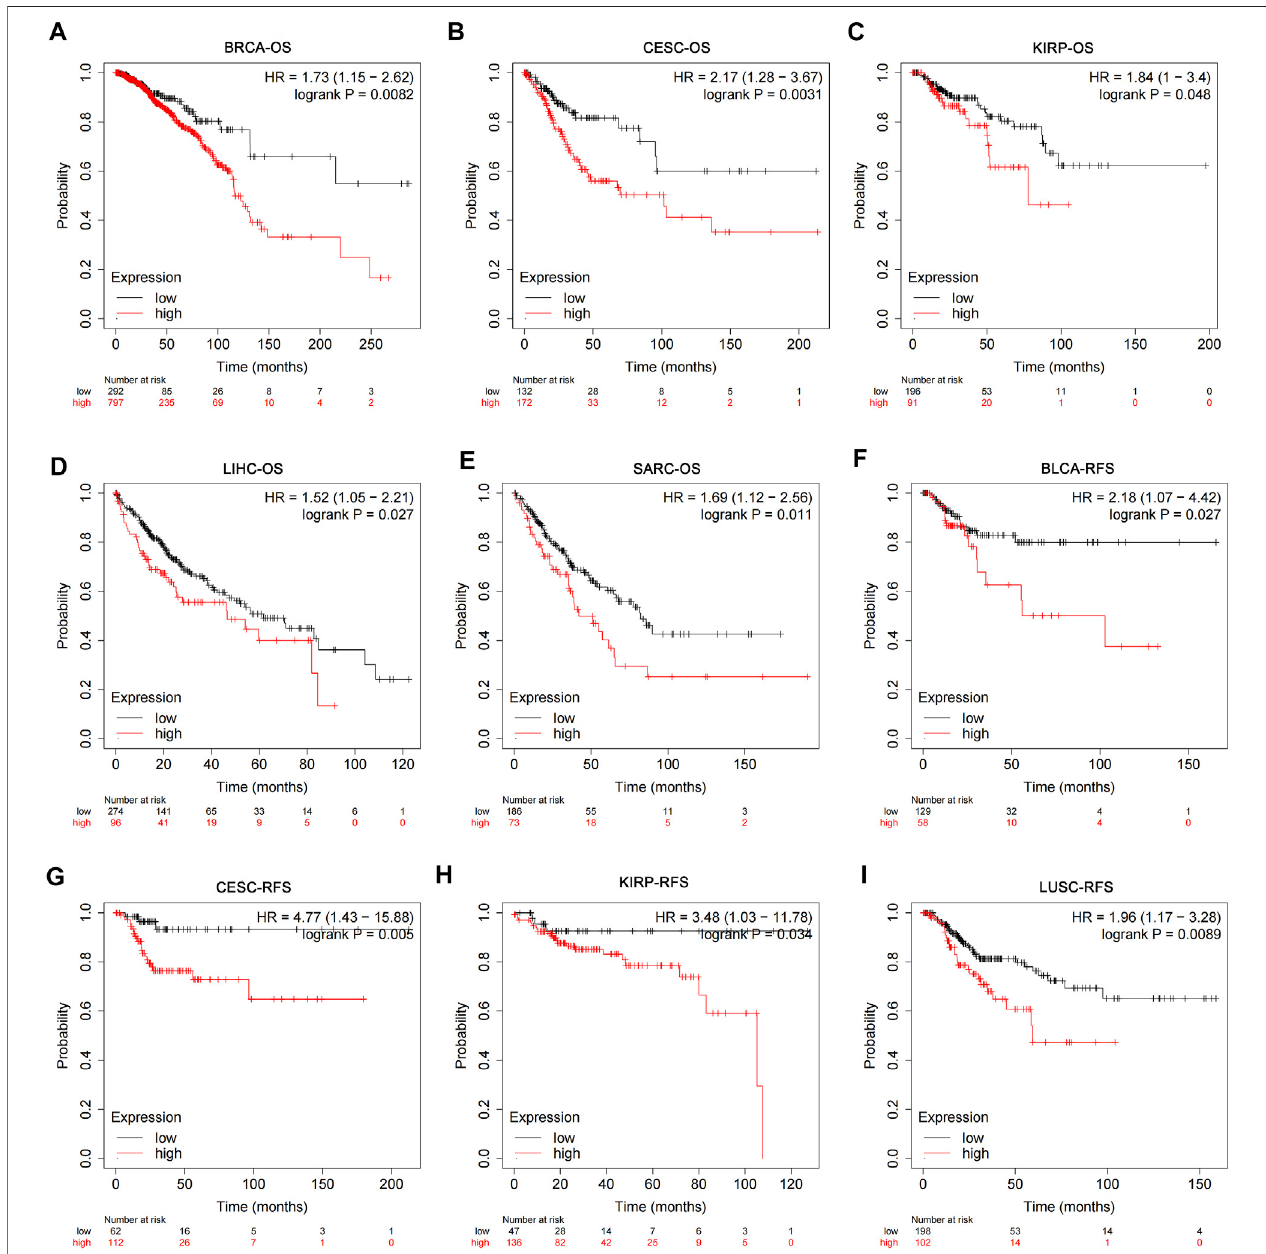
FIGURE 2 | Correlation analysis of USP45 with OS and RFS in patients with different types of tumors. The RNA-seq data and corresponding clinical information of different types of tumors were downloaded from TCGA database. The expression levels of USP45 were negatively correlated with OS of patients with BRCA (A) , CESC (B) ,KIRP (C) ,LIHC (D) ,andSARC (E) .TheexpressionlevelsofUSP45werenegativelycorrelatedwithRFSofpatientswithBLCA (F) ,CESC (G) ,KIRP (H) ,andLUSC (I)